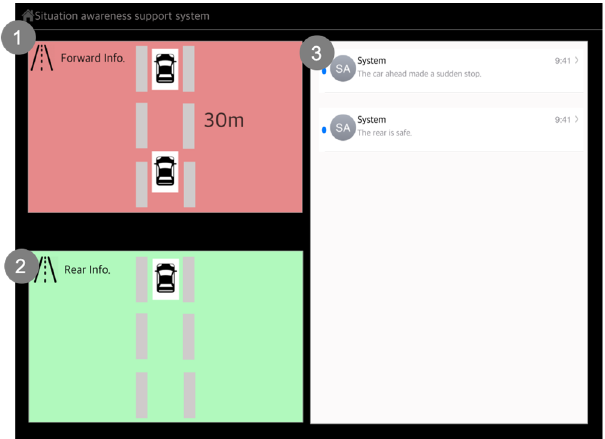
Figure 12. Descriptions of the interaction screen for a sudden braking situation (Source: Own creation): ( 1 , 2 ) The information covers a broad range of situations, but it focuses on the important. The driver’s attention becomes arousal through proactively blinking red and green colors and it switches from driving to the situation information fast [Direct Perception]; and ( 3 ) It supports [Active Communication]. The driver can communicate actively with a system and it can help comprehension of the situation.